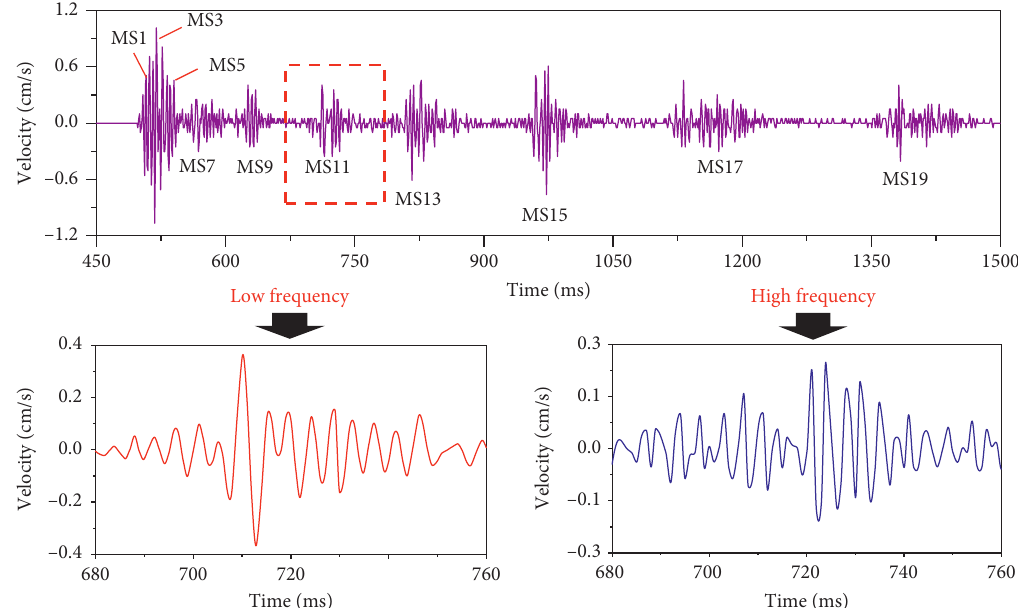
Figure 7: Filtering results of the monitored vibration waveform for MS11.